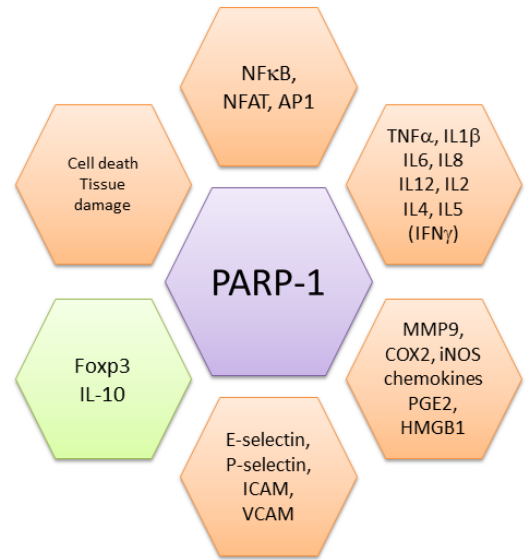
Figure 2. PARP-1 is ubiquitously expressed and plays a central role in inflammation (orange hexagons). By activating NF- κ B through several mechanisms (and also NFAT and AP1), PARP-1 induces the production of inflammatory (TNF α , IL1 β and others) and effector T cell cytokines (IL4, IL5). Inflammatory mediators activated by PARP-1 include metalloproteinases (MMP9), inducible nitric-oxide synthase (iNOS), several chemokines, prostaglandins (PGE2) and alarmins (HMGB1). It also favors cell recruitment through upregulation of adhesion molecules, including selectins and cell adhesion molecules (ICAM, Intercellular Cell Adhesion Molecule; VCAM, Vascular Cell Adhesion Molecule). When over-activated, PARP-1 also induces cell death and tissue damage, further fueling the inflammatory process. On the other side, PARP-1 inhibits the expression of Foxp3, a transcription factor required for regulatory T cell differentiation and function, and of IL10, an inhibitory cytokine (green hexagon).